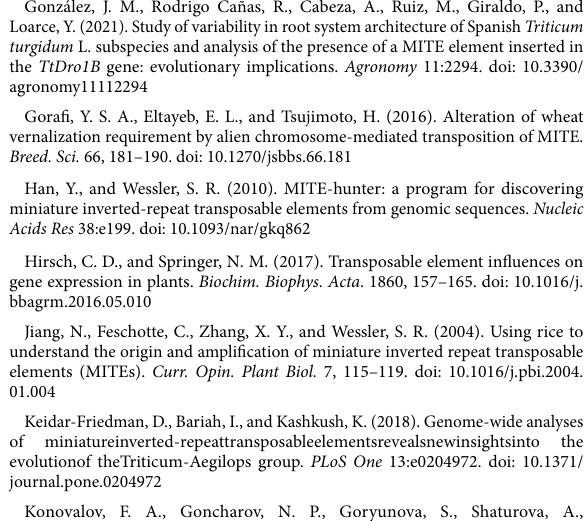
SUPPLEMENTARY FIGURE 1 An example of the segregation of a MITE marker (Minos-FN564434) in 104 Chinese Spring (P1) x SHW ABD. No.4 (P2) RIL mapping population. The genotypes of the two parental lines (CS and SHW) are